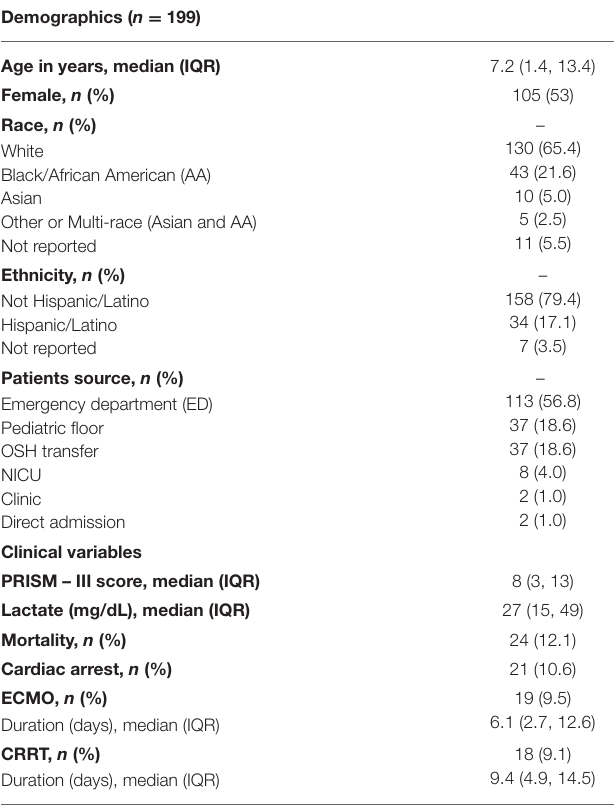
TABLE 1 | Demographic and clinical characteristics of patients with severe sepsis included in the